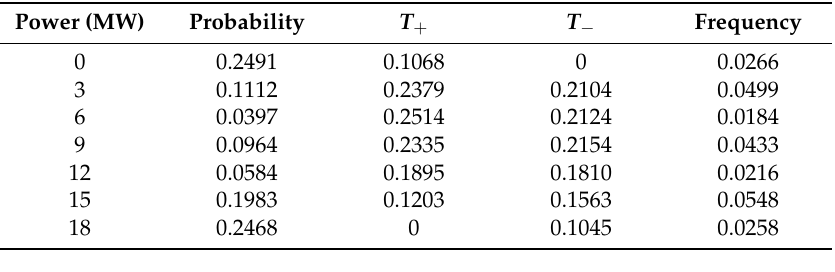
Table 2. Eighteen-megawatt wind farm output power stochastic model.